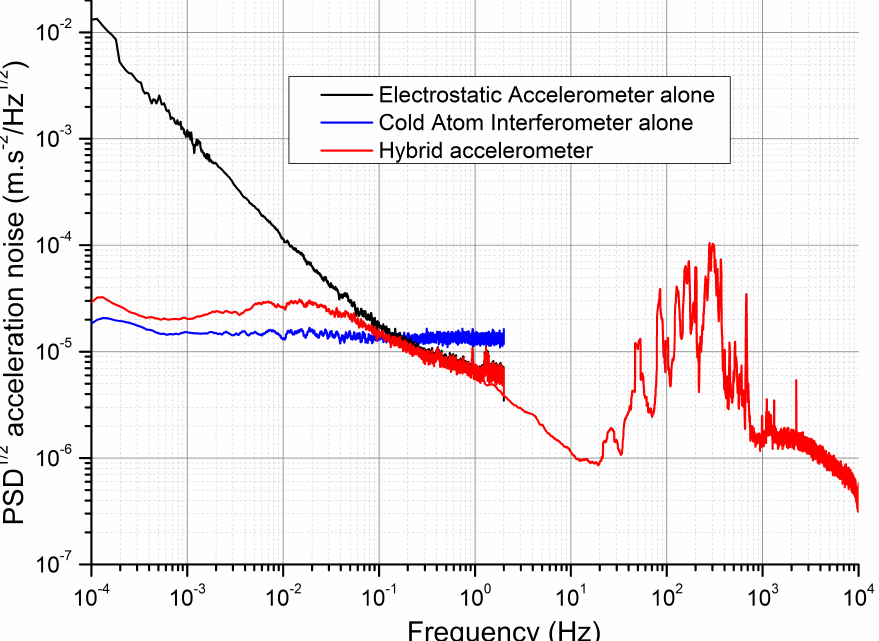
Figure 17. ASD acceleration noise for the EA (black curve), the cold atom gravimeter (blue curve), and the EA corrected by the CAI through a hybridization algorithm (red curve). The interrogation time of the CAI was set to T = 20 ms to highlight the interest of hybridization and reproducing qualitatively the noise assumptions treated in the numerical gravity simulations. Note that, at a high frequency ( 1 Hz), the red curve is completely superimposed on the black